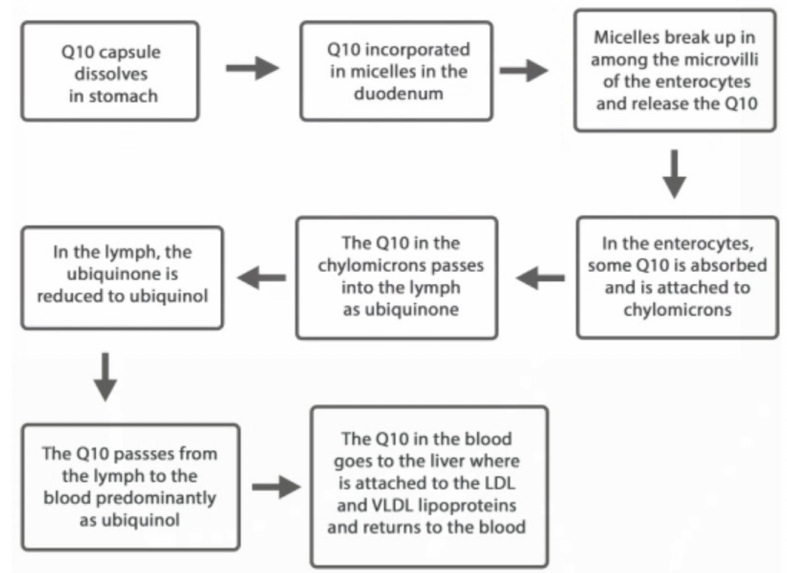
Figure 1. The transit of the ingested CoQ 10 from the stomach to the blood